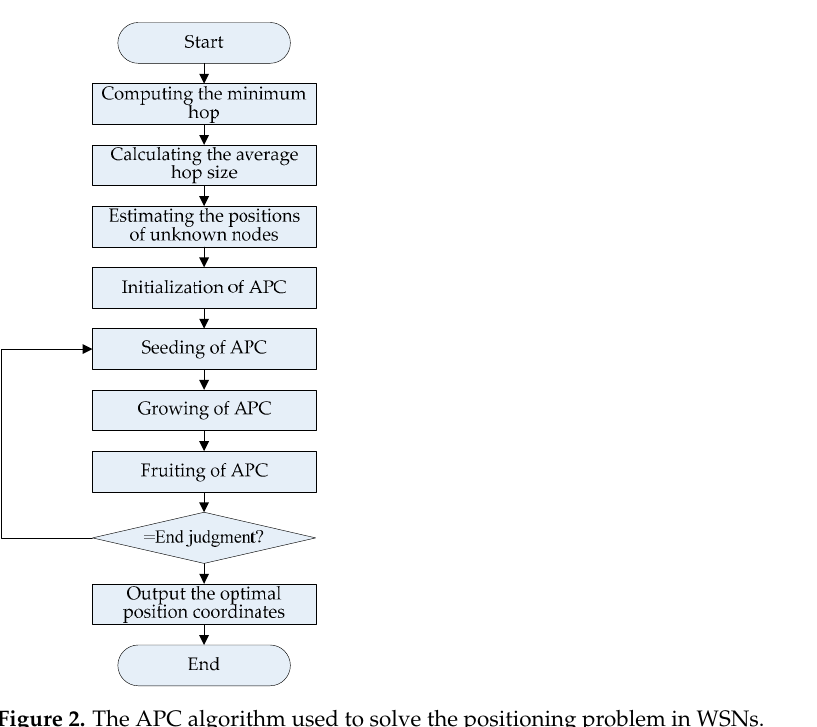
Figure 2. The APC algorithm used to solve the positioning problem in